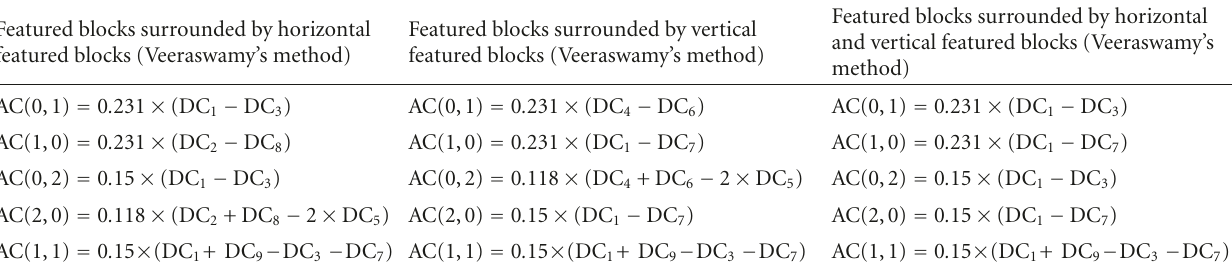
Table 2: The formulas to estimate the first five AC coe ffi cients of each 4 × 4 DCT block (2). Featured blocks surrounded by horizontal Featured blocks surrounded by horizontal Featured blocks surrounded by vertical and vertical featured blocks featured blocks (Veeraswamy’s method) featured blocks (Veeraswamy’s method)